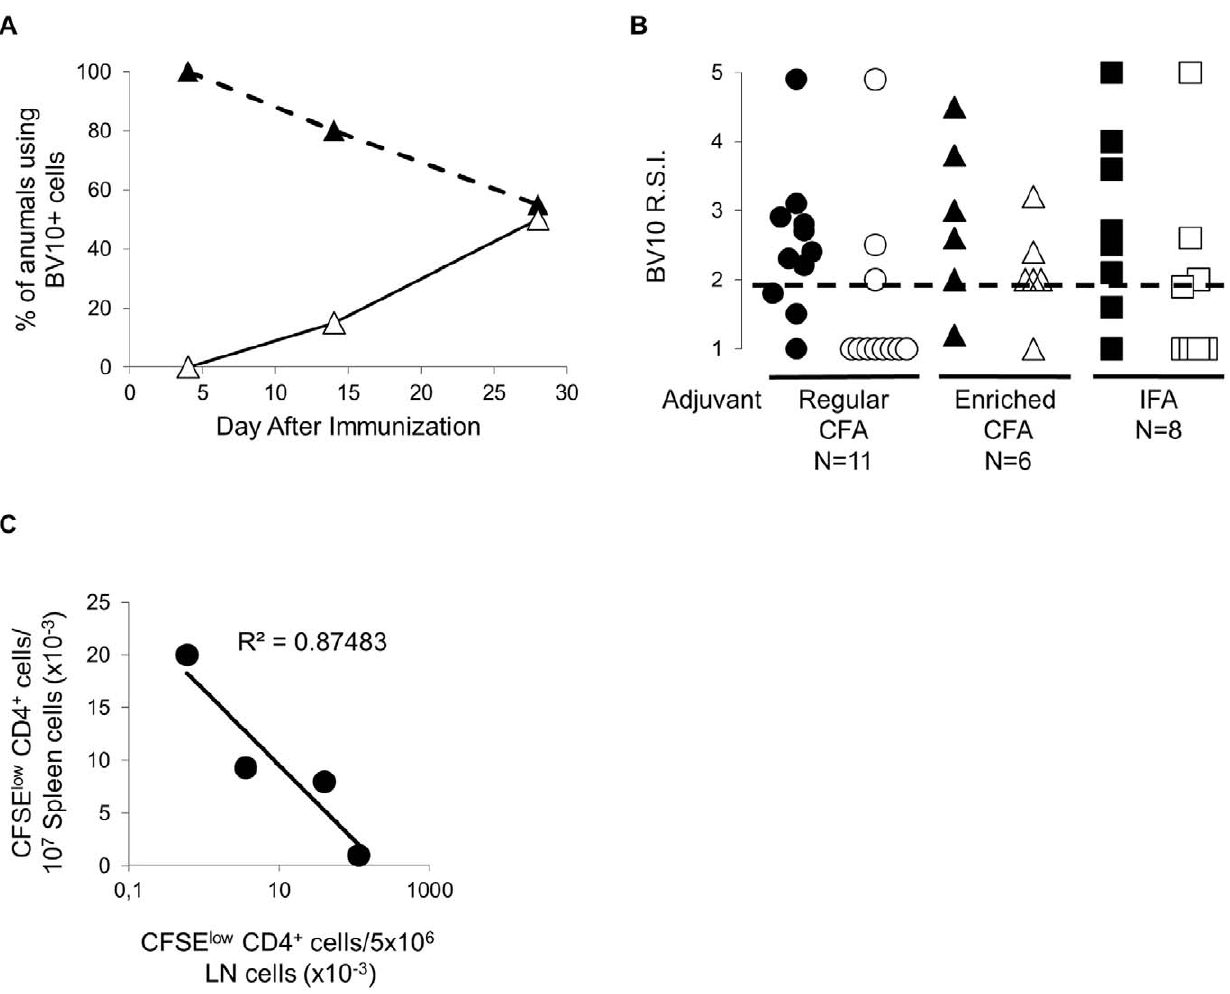
Figure 1. Amount of M tuberculosis in the adjuvant modulates appearance of p139-specific-T cells in the SJL strain. SJL mice were immunized with p139 in IFA containing or not 50 or 200 microgrammes/mouse of M tuberculosis (regular or enriched CFA, respectively). In all the figures, closed symbols refer to LN cells and open symbols to spleen cells. A ) Time course of appearance of p139-specific BV10 + cells in LN and spleen following challenge with antigen in regular CFA. BV10 + , p139-specific T cells were measured by immunoscope in draining LN and spleen. B ) Presence of p139-specific BV10 + cells in the spleen at d 14 after s.c. immunization depends on the amount of M tuberculosis in the adjuvant. SJL mice were immunized s.c. with 100 microliters of a 1:1 suspension of p139 in regular CFA (11 mice), in enriched CFA (6 mice) or in IFA alone (8 mice). Two weeks later, mice were sacrificed and LN and spleen were examined for the presence of p139-specific BV10 + cells by immunoscope. Data are reported as R.S.I., and each symbol represents LN or spleen of one mouse, and the dashed line represents the cut off value for positivity in SJL mice. c ) The number of p139 specific T cells in the spleen 14 d after challenge with peptide in enriched CFA is inversely related to the number of the same cells in the LN. SJL mice were immunized s.c. with p139 in enriched CFA (4 mice). Two weeks later, cells from draining LN and spleen were stained with CFSE and cultured in the presence or absence of 10 microgrammes/ml of p139. After 3 days, cells were recovered and stained with PE-labelled anti CD4 monoclonal antibody. p139-specific cells are calculated as CFSE low CD4 + cells in the ag-stimulated sample minus the number of the same cells in the non-stimulated sample.